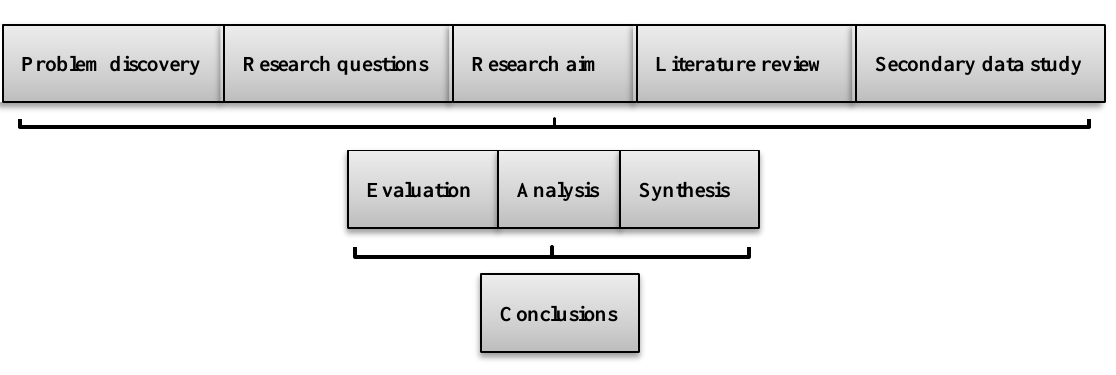
Figure 1. Flow chart of the research methodology.